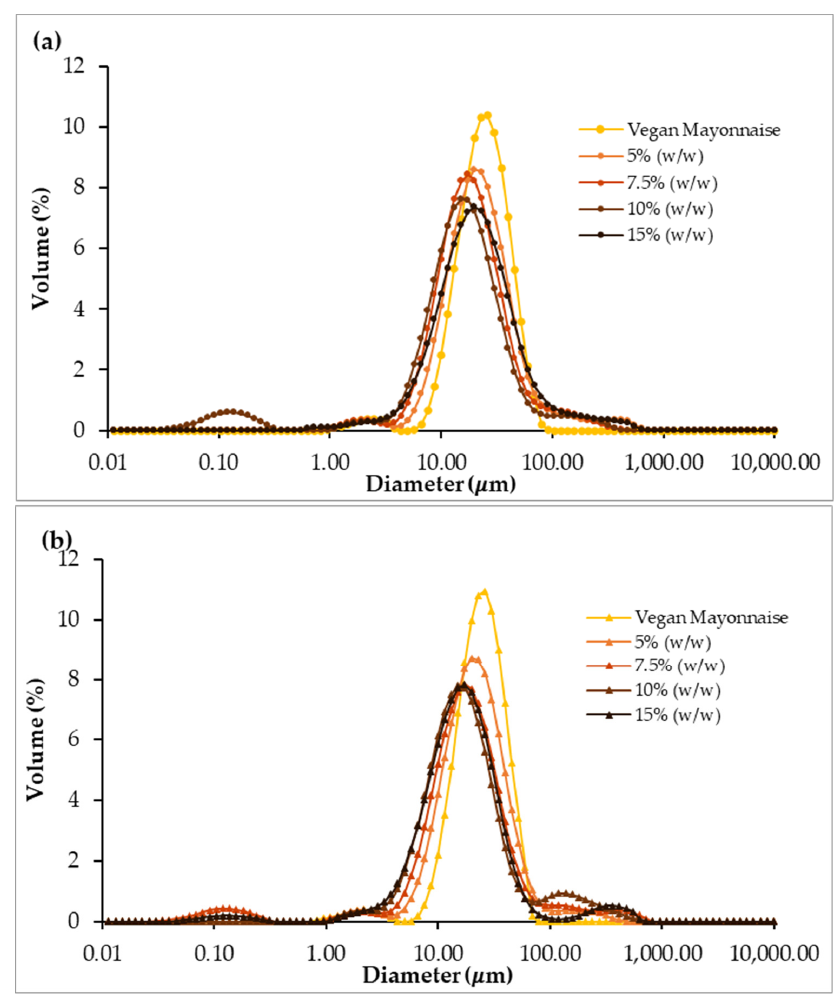
Figure 8. Comparison of droplet size distribution of emulsions with 5, 7.5, 10 and 15% ( w / w ) of miso paste and standard emulsion, measured 1 ( a ) and 30 ( b ) days after emulsion preparation.